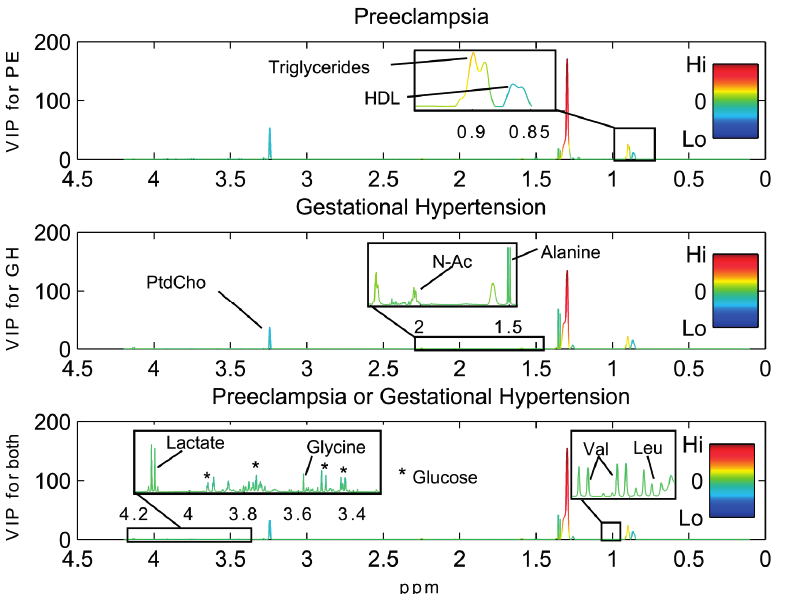
Figure 3. Serum variables involved in predicting preeclampsia and/or gestational hypertension by partial least squares discriminant analysis PLS-DA. The variable importance in projection (VIP) scores for each variable are shown along the vertical axis.